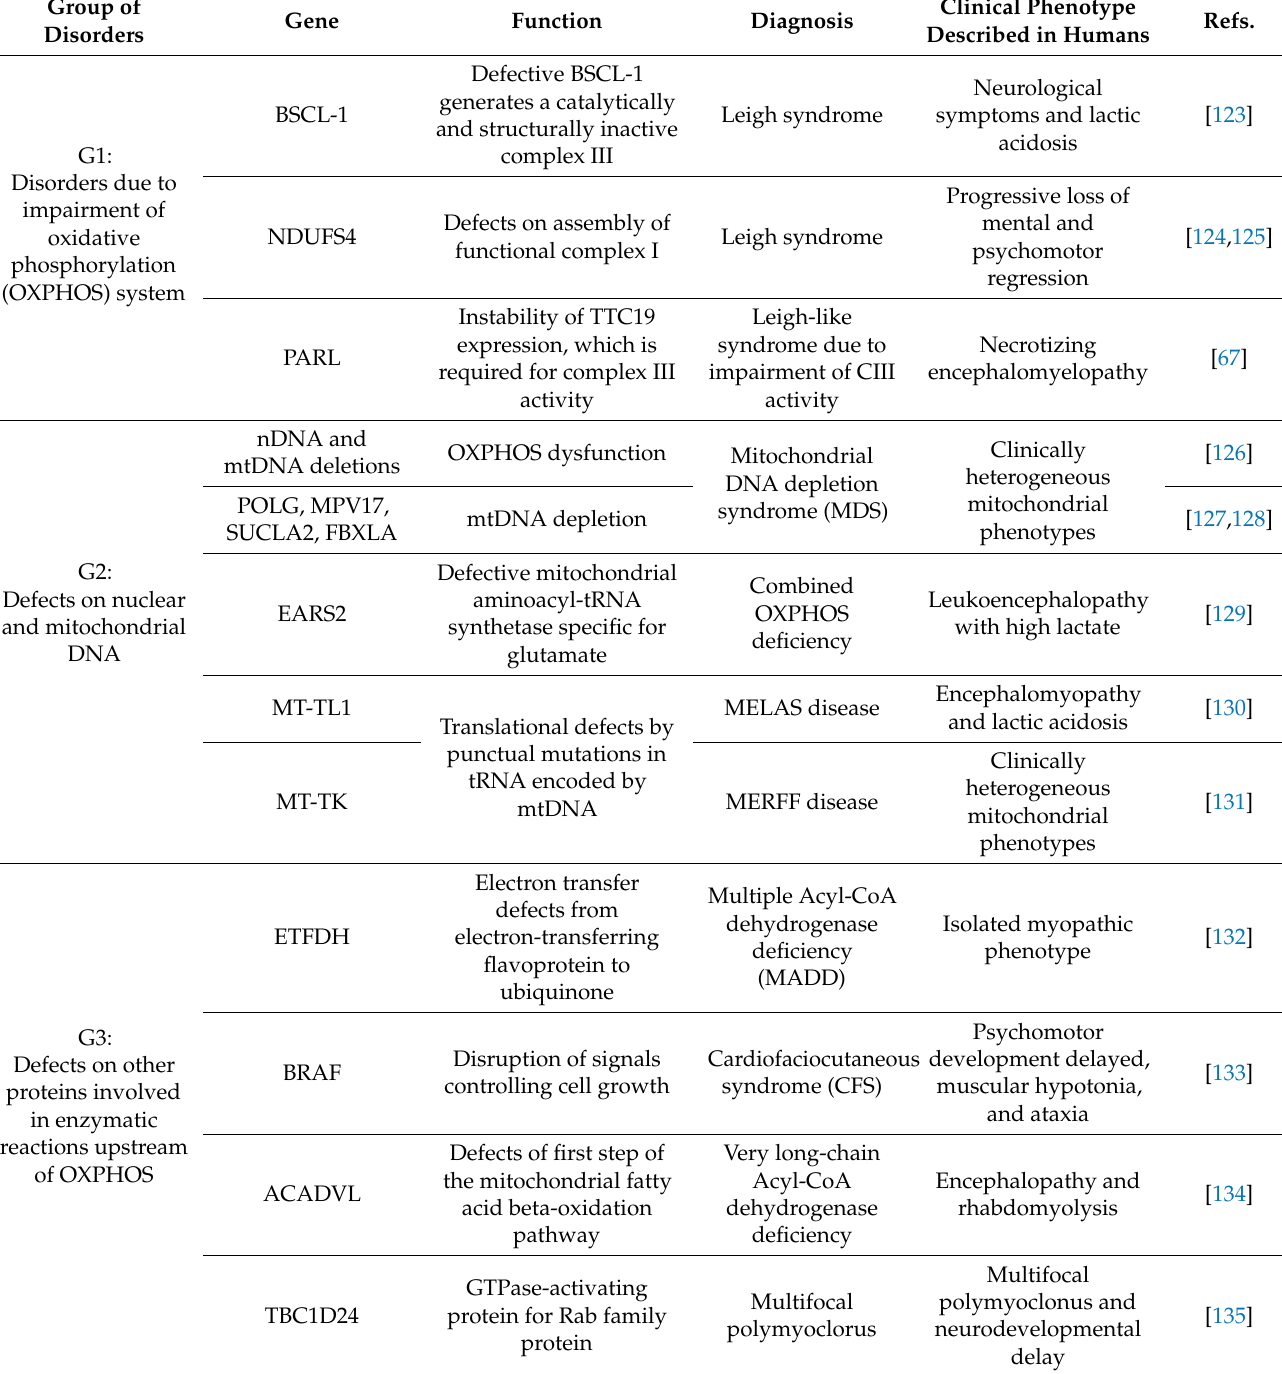
Table 1. Groups of disorders associated with secondary CoQ